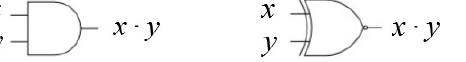
Figure 1. Basic implementation scheme of a SC multiplier in the (0..1) range (AND gate, left ) and in the ( − 1..1) range (XNOR gate, right ).